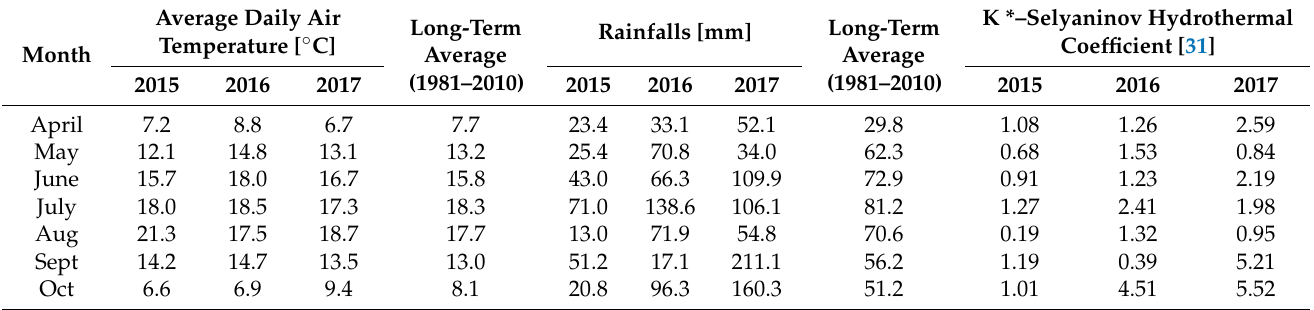
Table 2. Characteristics of the meteorological conditions during the